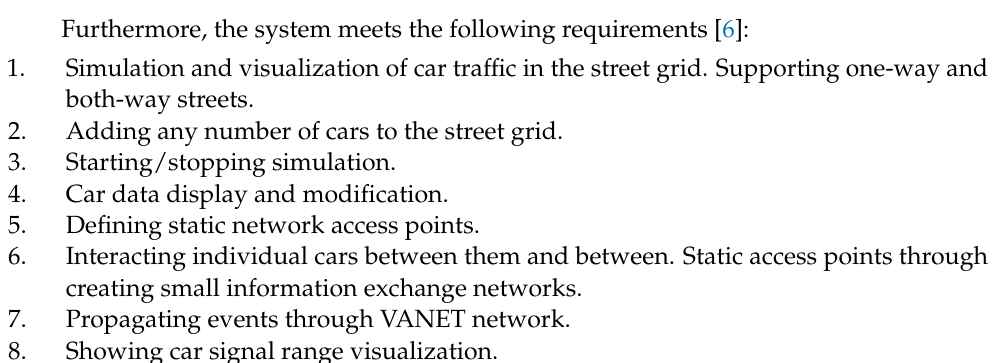
Figure 9. Main view of the application of VANET network to mock the road